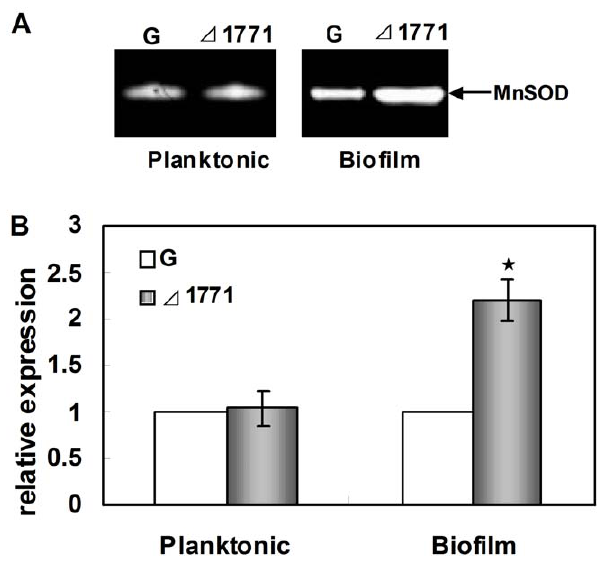
Figure 1. Expression of SOD in D 1771 mutant. Planktonic cells were cultured in TSB with shaking (180 rpm) overnight for stationary phase. Biofilm cells were cultured in a Petri dish containing 20 ml of TSB medium and a sterilized glass slide at 37 u C for 3 days. Sessile biofilm cells of both strains grown on glass slides were scraped off with cotton sticks, resuspended in distilled physiological saline, and subsequently harvested by vortexing the sticks. (A) Detection of the SOD activity in the acrylamide gels. Extracts from cells grown in planktonic and in biofilms were separated on a nondenaturing polyacrylamide gel and stained for SOD activity. (B) Transcription analysis of the sod gene using RT-qPCR. The transcription level of the sod gene in the wild-type (G) were used as the standard. The columns represent mean fold changes, and error bars show standard deviations of the means (n=9). Star marker indicated that fold-changes were significant different ( p - value , 0.05).